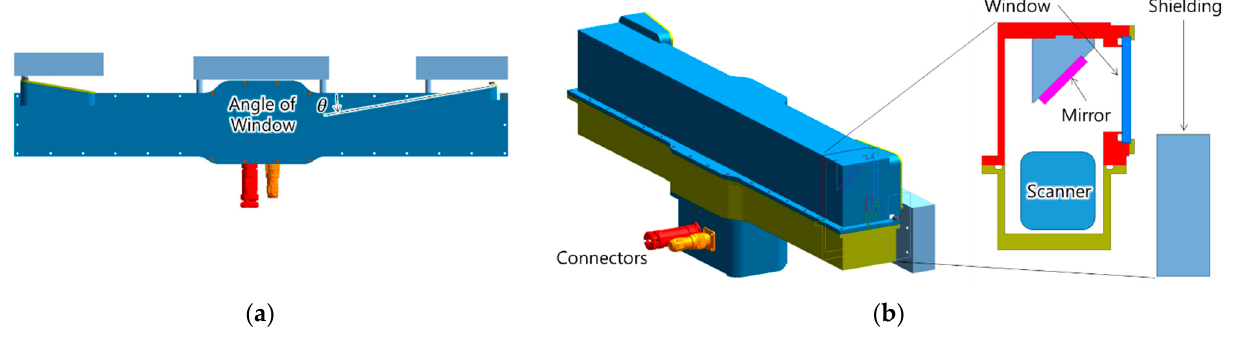
Figure 4. Housing Design: ( a ) Top View; ( b ) Isometric View.